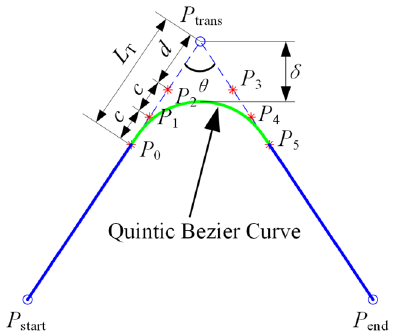
Figure 1 Quintic Bezier curve between two adjacent line